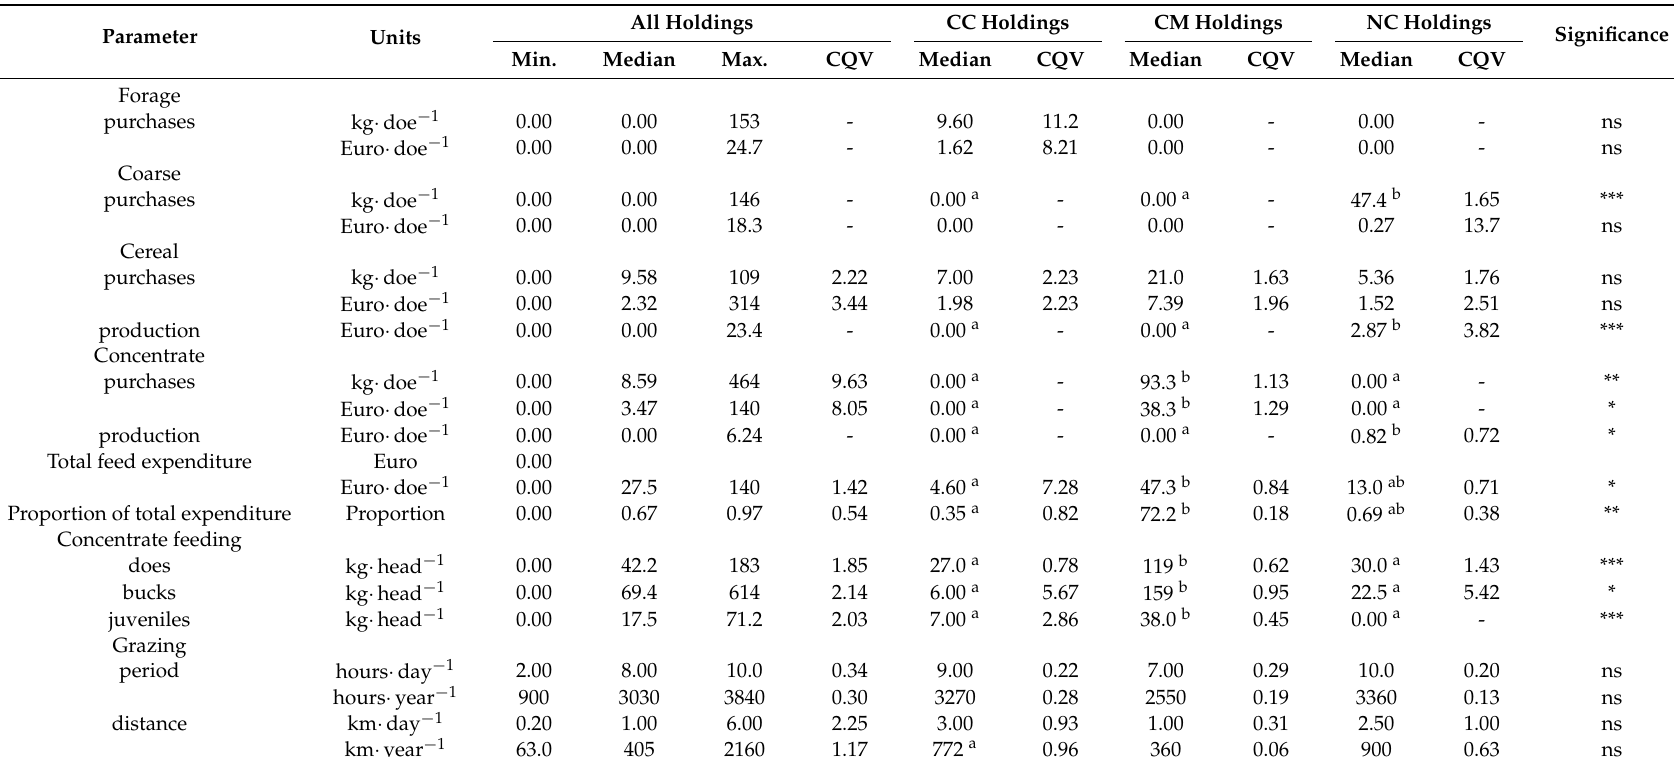
Table 7. Descriptive statistics for parameters relating to the feeding and grazing practices on ten goat holdings in the northern region of Morocco based on monthly data collections between September 2009 and August 2012. Holdings are classified by their dairy production status: commercial cheese (CC, n = 3), commercial milk (CM, n = 4) and undiversified (NC, n =